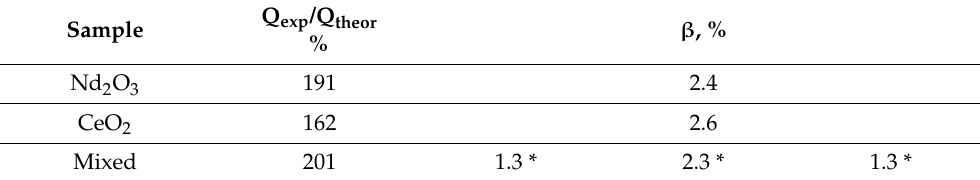
Table 4. Determination of the reduction degree of REM oxides to metals using the bromine method.